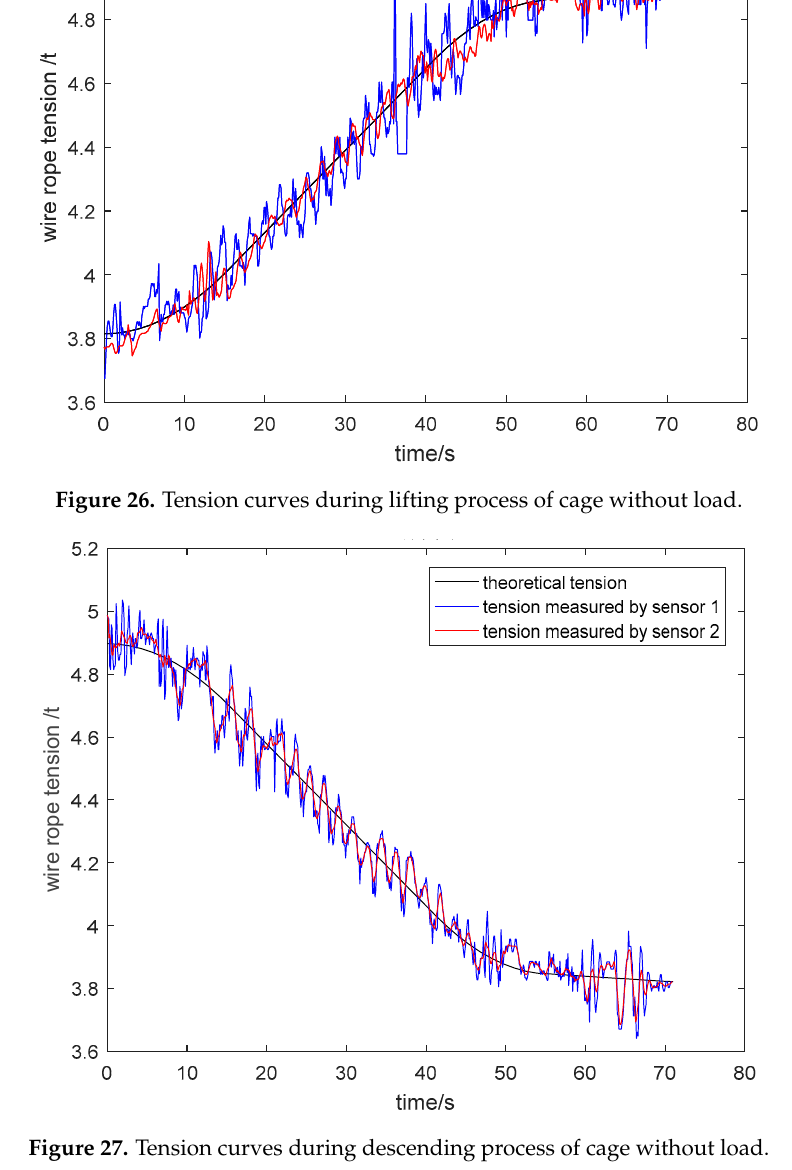
Figure 27. Tension curves during descending process of cage without load.